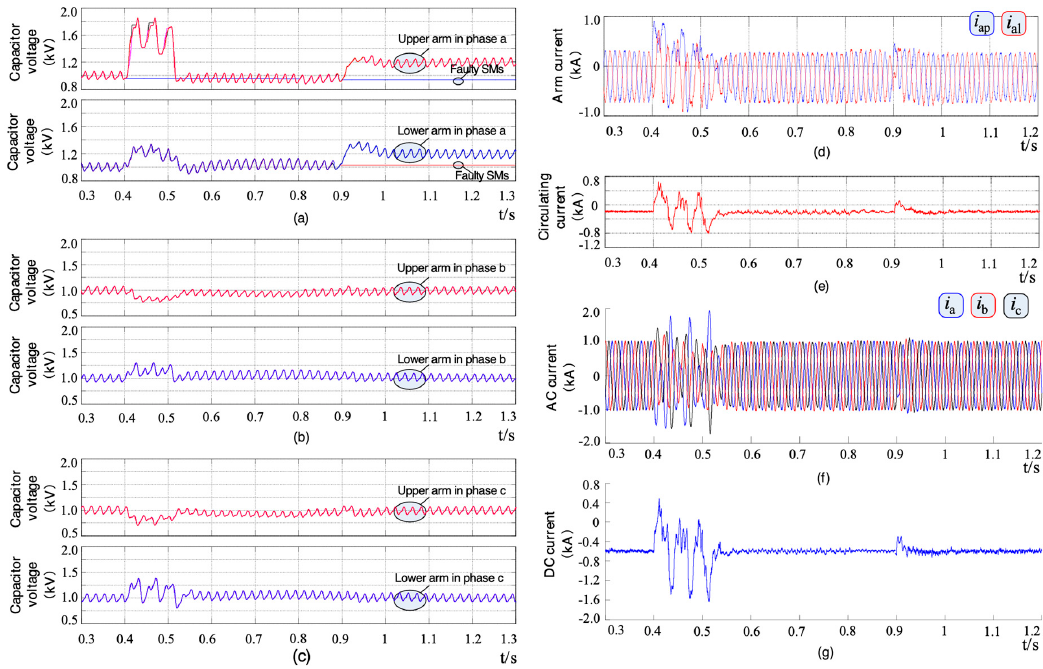
Figure 9. Simulation results of fault condition 1: ( a ) Capacitor voltage of phase a; ( b ) Capacitor voltage of phase b; ( c ) Capacitor voltage of phase c; ( d ) Arm current of phase j (j = a,b,c); ( e ) Circulating current of phase j (j = a,b,c); ( f ) AC current; ( g ) DC-link current.